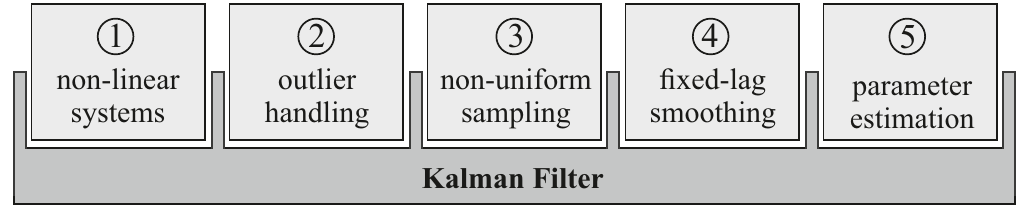
Figure 1. Overview of the presented features and their combination with the original